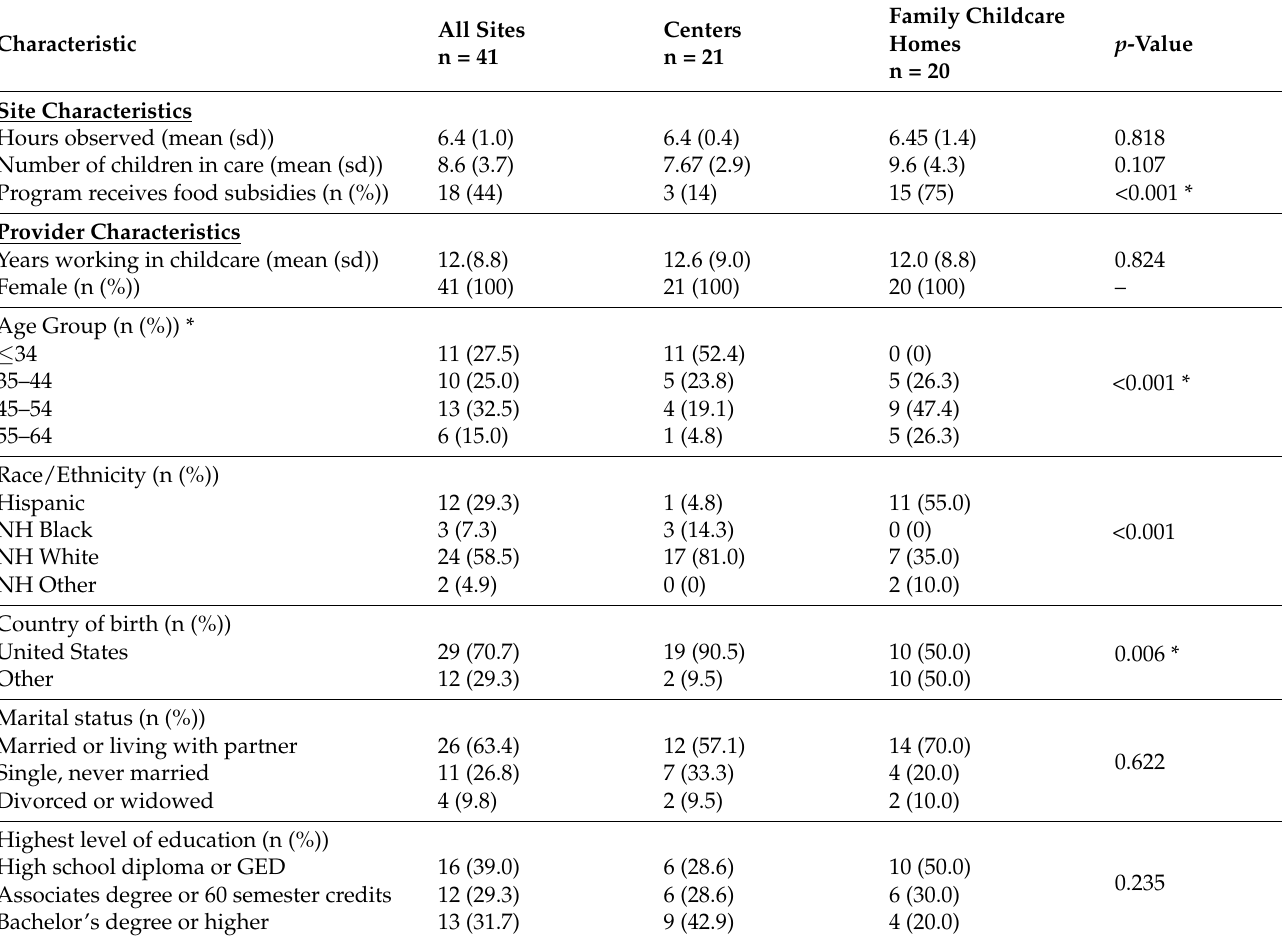
Table 1. Sample Demographics and Other Characteristics, Overall and by Site